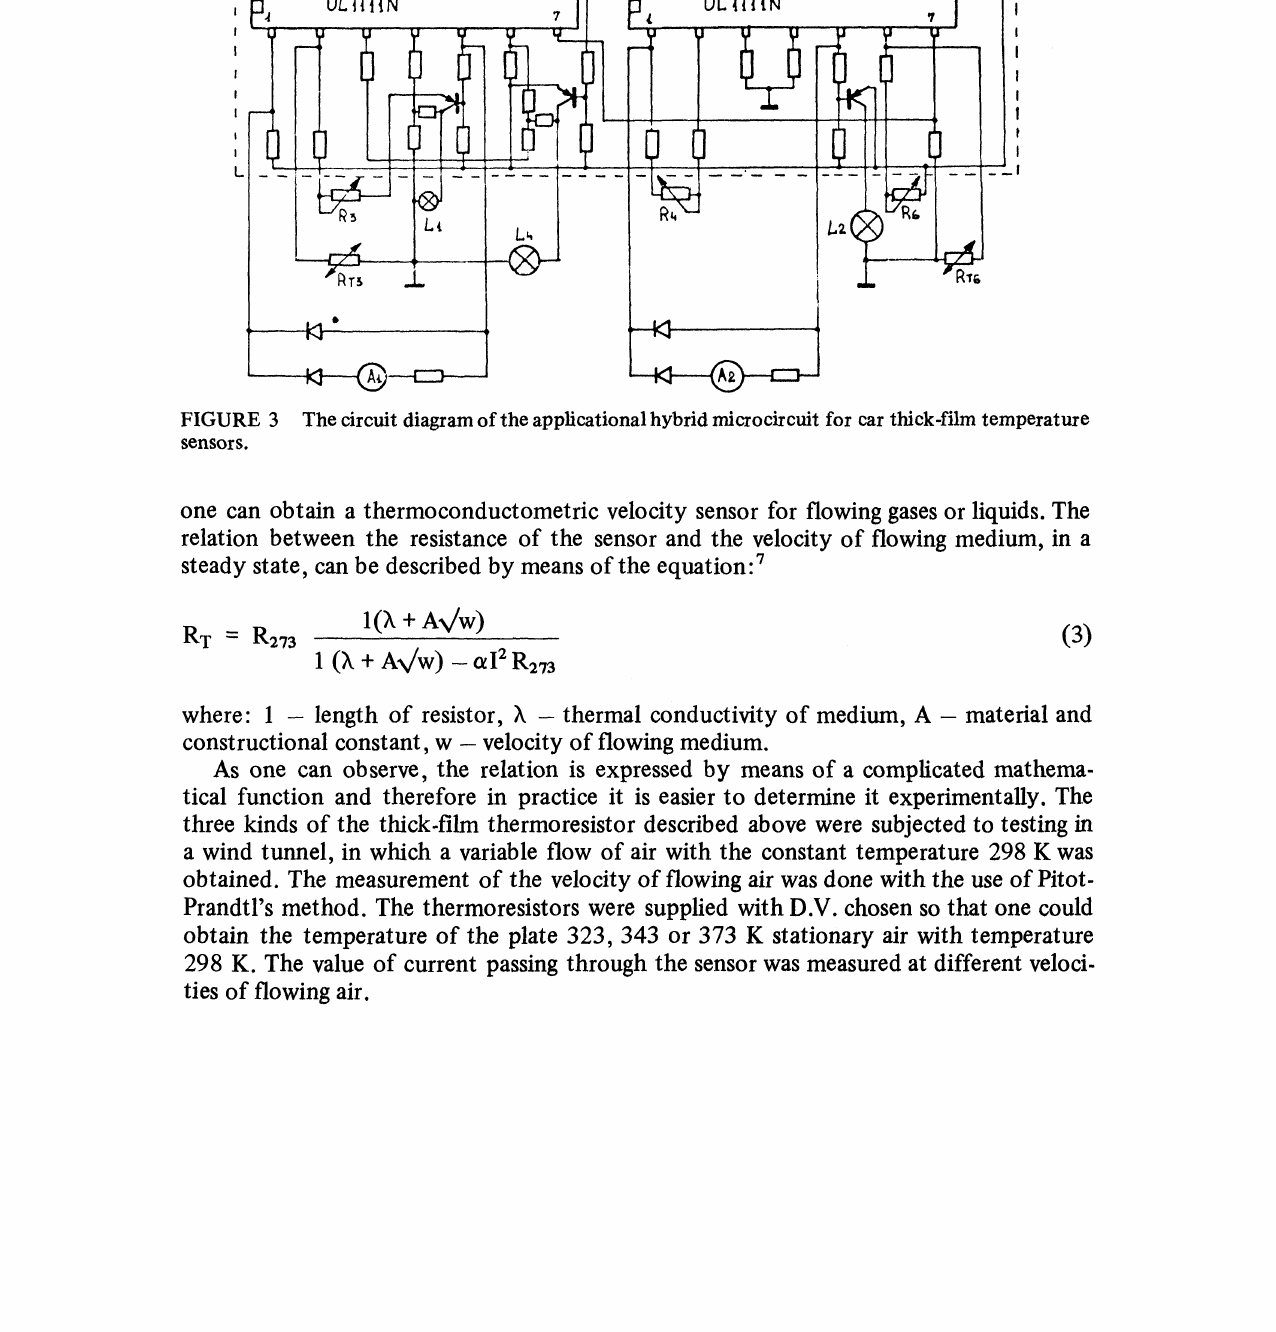
FIGURE 3 The circuit diagram of the applicationalhybrid microcircuit for car thick-film temperature